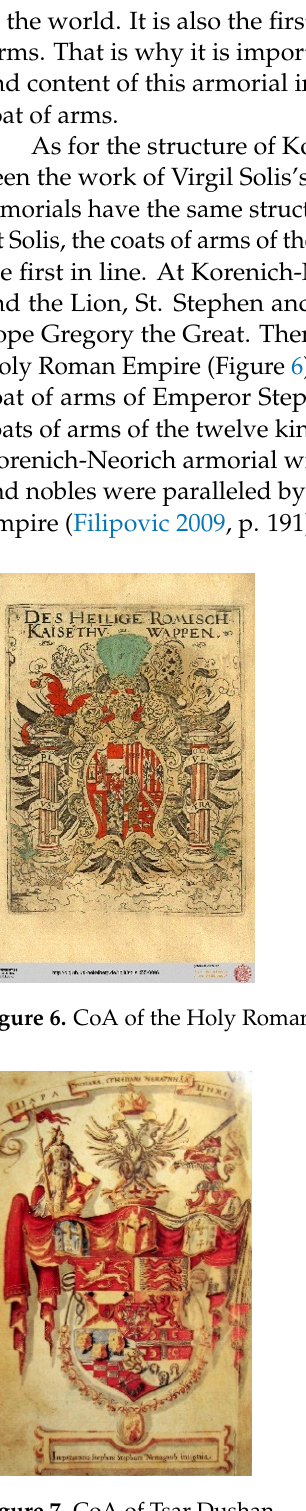
Figure 7. CoA of Tsar Dushan.